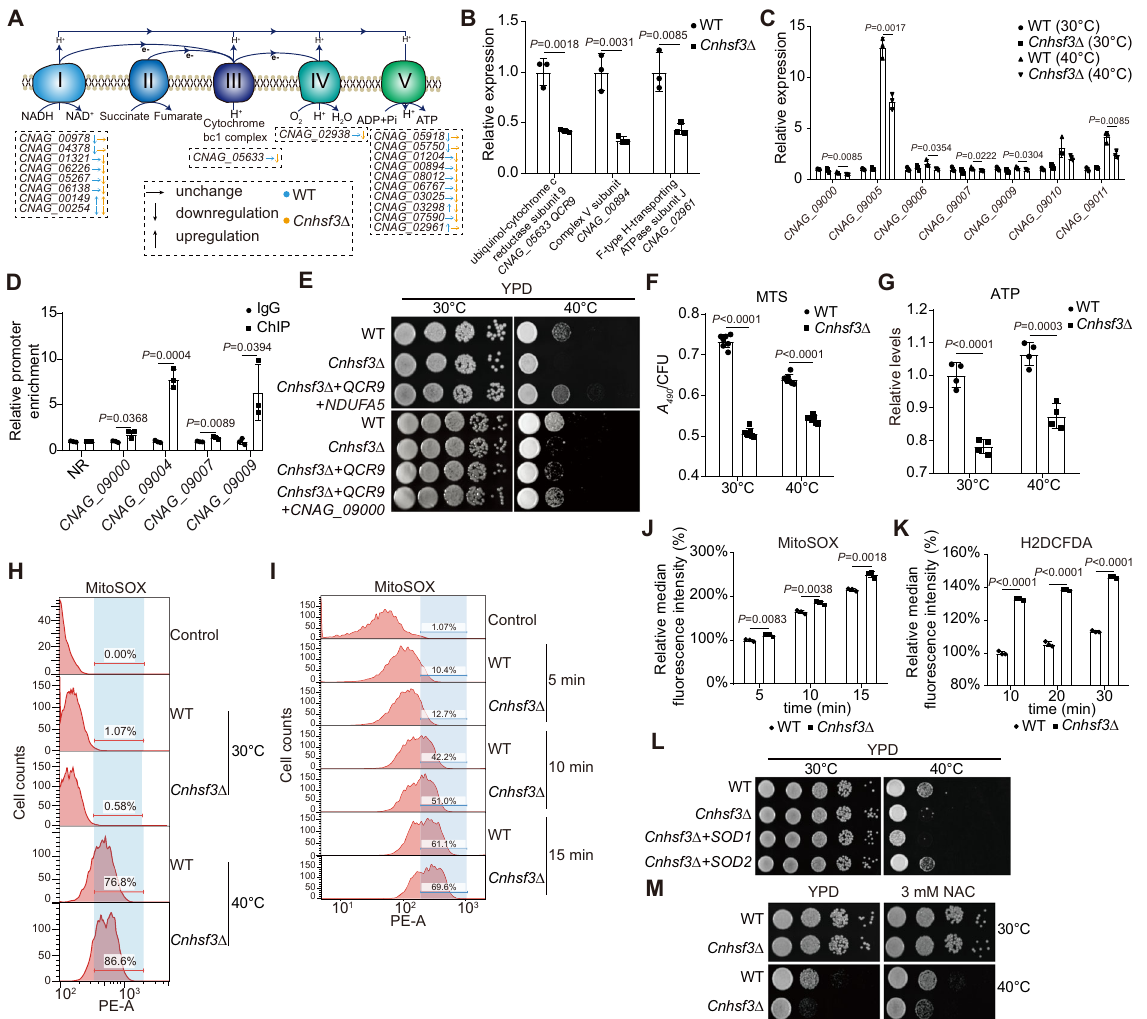
Fig.3|CnHsf3repressesmtROSproductionbyactivatingETCgeneexpression. A ETC gene regulation scheme in Cnhsf3 Δ from RNA-seq results. Regulation